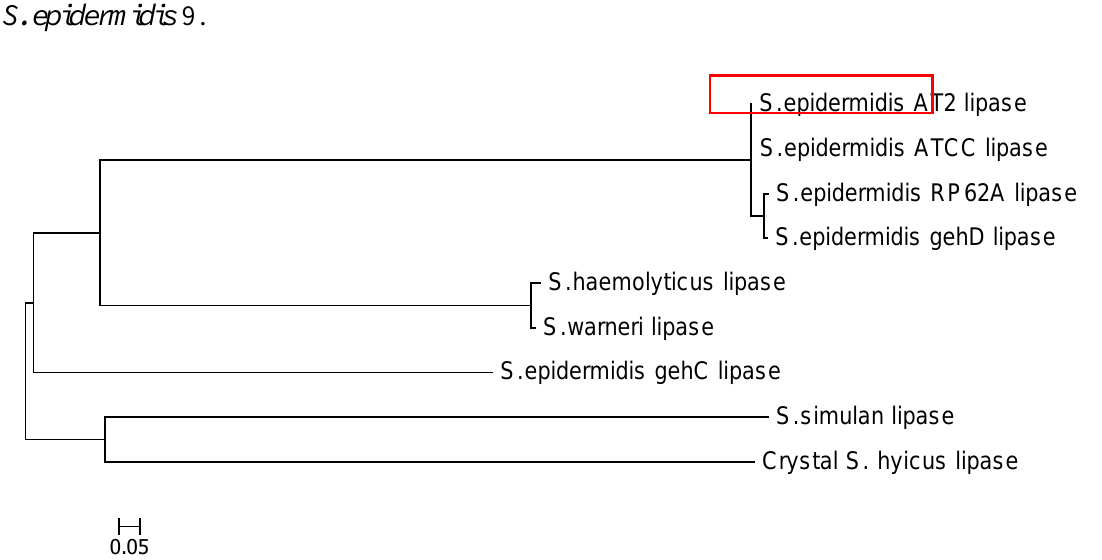
Figure 3. The phylogenetic analysis showed that AT2 lipase is closely related to S. epidermidis ATCC lipase, S. epidermidis RP62A lipase and lipase gehD